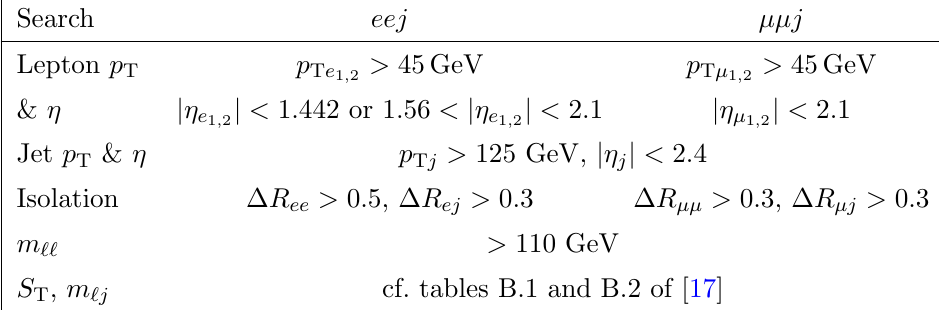
Table 3. Summary of selection cuts for CMS single-leptoquark production search [17]. Cuts on the sum of transverse momentum S T and m ‘j depend on the assumed leptoquark mass. Details can be found in tables B.1 and B.2 of [17] where generator level and a higher-level cuts on m ‘j are